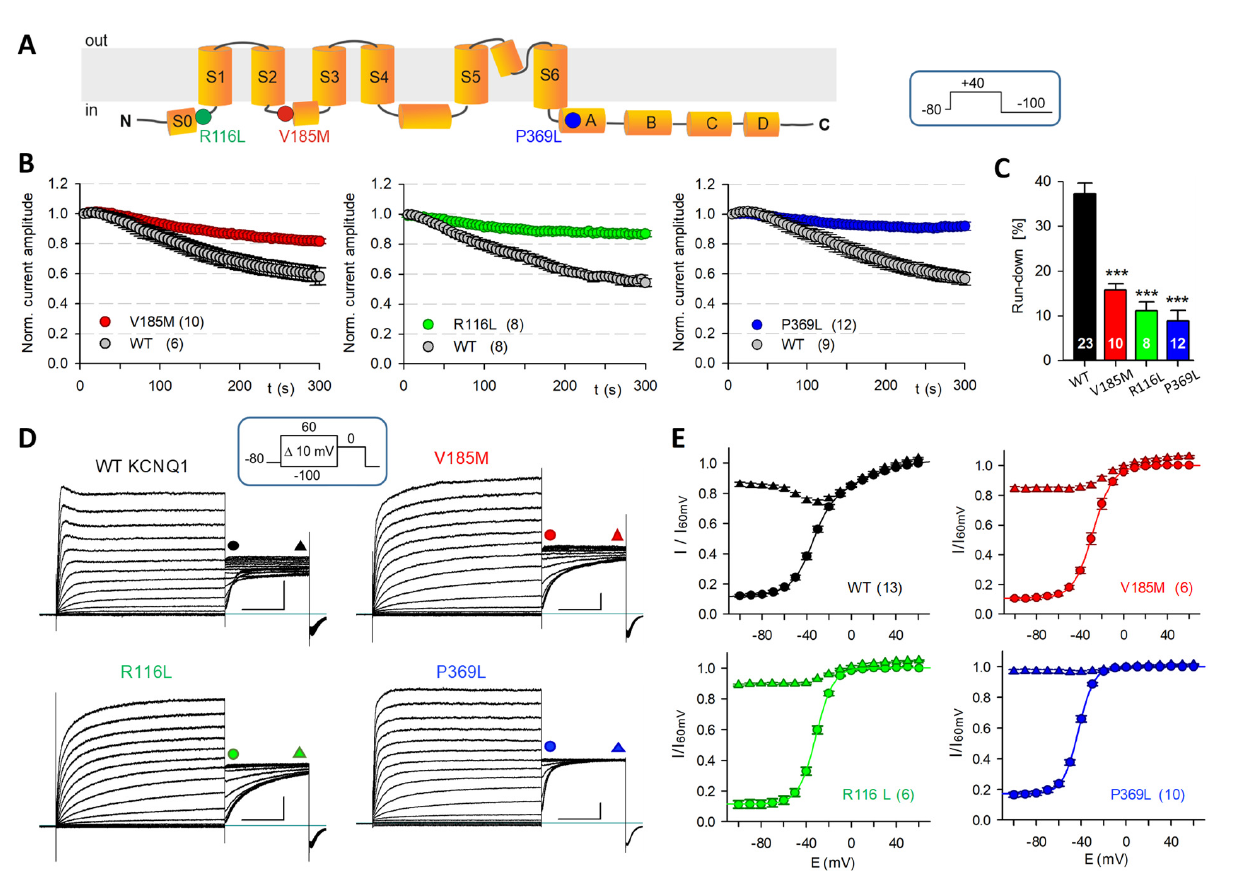
Figure 2. All three disease-associated KCNQ1 variants lead to reduced early current run-down. ( A ) Scheme of the membrane topology of a KCNQ1 subunit with the location of the three studied amino acid substitutions indicated as colored dots. Transmembrane segments S1–S4 constitute the voltage-sensing domain, and S5 and S6 the pore domain. The cytoplasmic C-terminus harbors the proximal helices A and B and the distal helices C and D. ( B ) Whole-cell membrane currents were recorded in CHO cells expressing WT or mutant KCNQ1 channels using standard ECS and ICS. The time course of -current run-down was traced with a 500 ms test pulse to 40 mV every 5 s. Normalized current amplitudes (means ± SEM) for V185M, R116L and P369L are plotted together with the WT data of closely paralleled experiments. ( C ) Mean relative current amplitudes 3.5 to 4 min after the first measurement in the whole-cell configuration. Asterisks indicate significant differences to the combined WT data; *** p < 0.001. ( D ) Typical families of current traces, recorded after a 5 min tracing period with the indicated standard double pulse current–voltage (IV) protocol. Scale bars denote 250 pA and 0.5 s. ( E ) Mean ( ± SEM) normalized instantaneous P2 current amplitudes (GV relation) and current amplitudes measured at the end of the 1 s P2 pulse to 0 mV are plotted against P1 potential (see symbols in D ). GV data points were fitted with a single Boltzmann function for the mutants and with a double Boltzmann function for WT KCNQ1 channels. Numbers of experiments are shown in